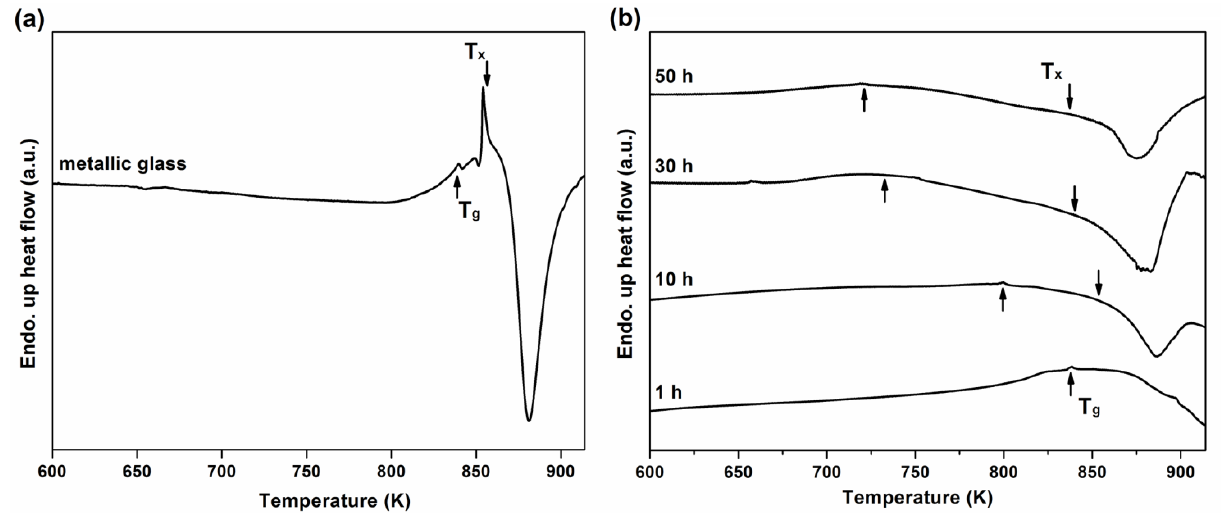
Figure 2. DSC scans ( a ) of the gas-atomized Fe 50.1 Co 35.1 Nb 7.7 B 4.3 Si 2.8 powder and ( b ) of the composite powders milled for 1, 10, 30 and 50